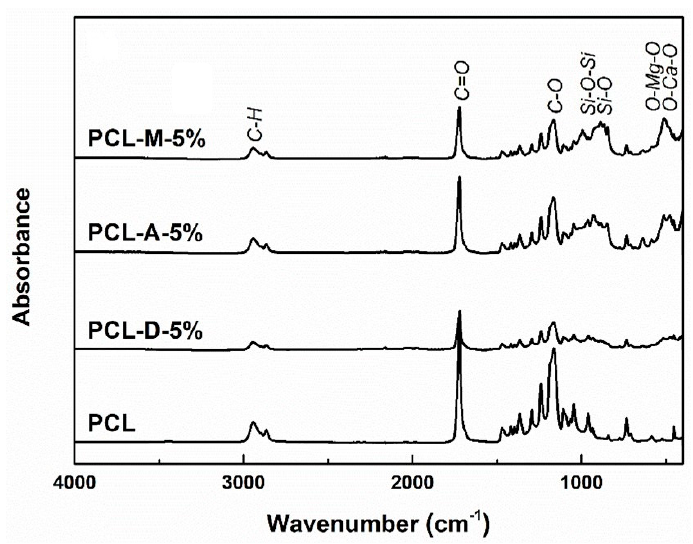
Figure 4. FTIR spectra of the electrospun samples with 5% powder loading.